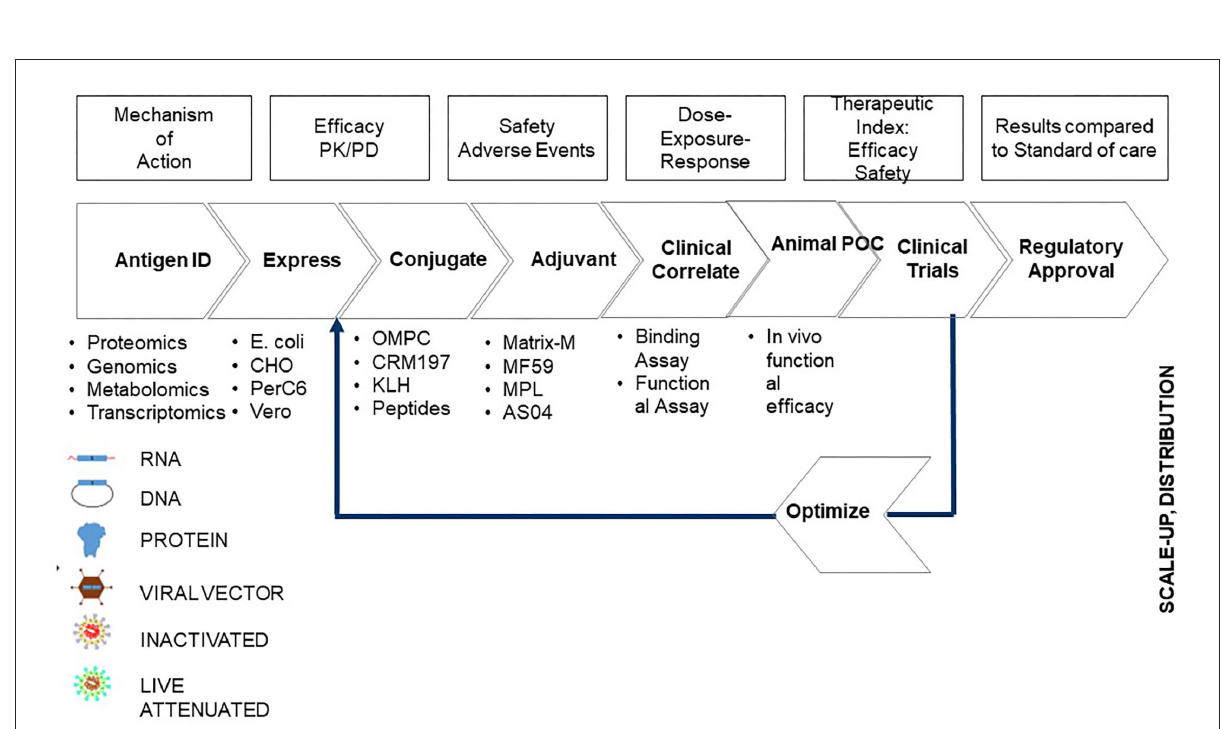
FIGURE2 Steps involved in vaccine development. Chemistry, Manufacturing, and Controls (CMC) is the step that involves process development and scale-up of the method of developing the vaccine.